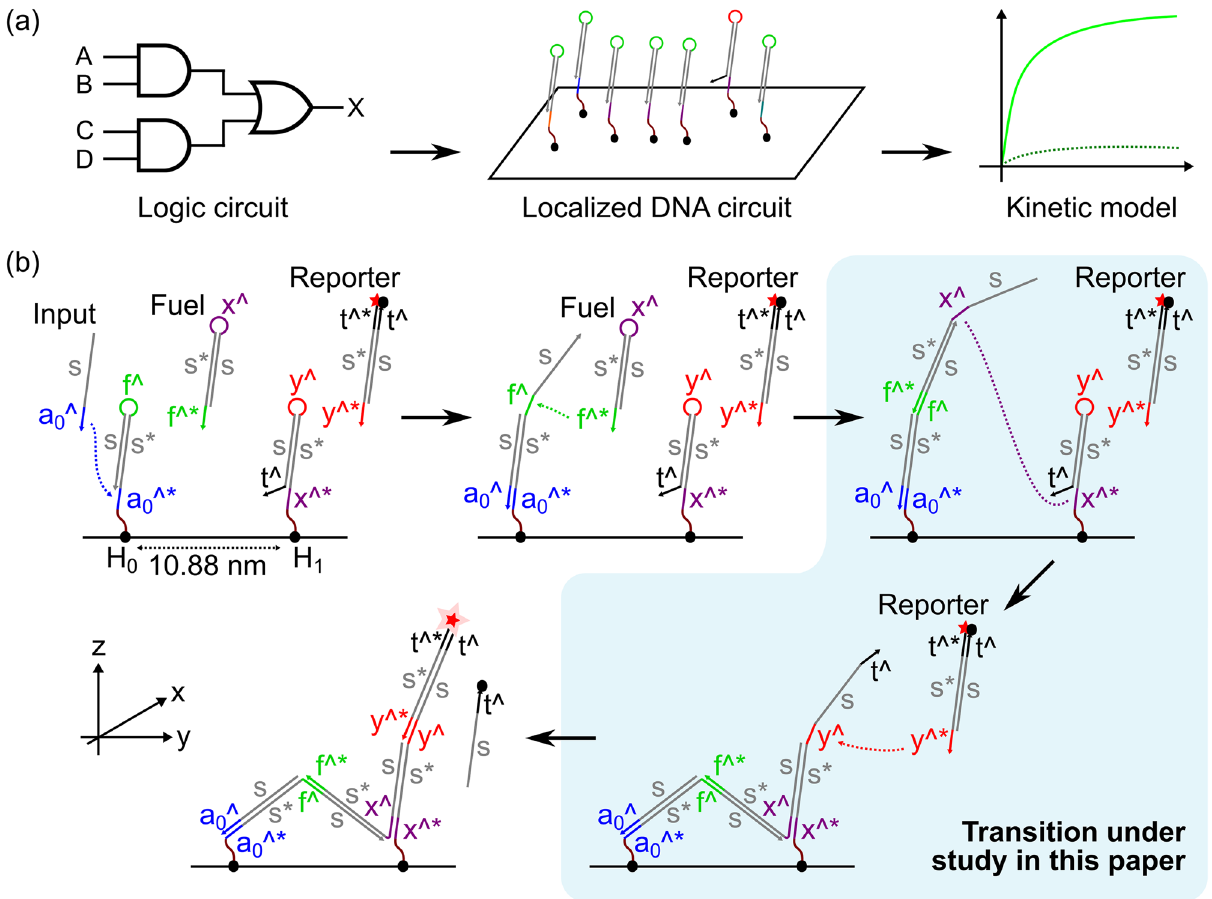
Figure 1. Outline of this work and the system under study. ( a ) Boolean logic circuits can be converted into localized DNA strand displacement cascades on the surface of a DNA origami tile, as previously demonstrated 4 . This paper concerns the automated conversion of such circuit designs into kinetic models by estimating reaction rate constants. ( b ) Cartoon of a two-hairpin signal transmission wire 4 . Binding of an input strand opens the first hairpin ( H 0 ), enabling a fuel hairpin to bind to it. The opened fuel hairpin can then interact with the second hairpin ( H 1 ), opening that too. The opened H 1 hairpin can then activate the reporter, producing a fluorescent output. The shaded blue area indicates the specific transition under study in this paper. Also shown are the directions of the axes that will be used throughout this paper.